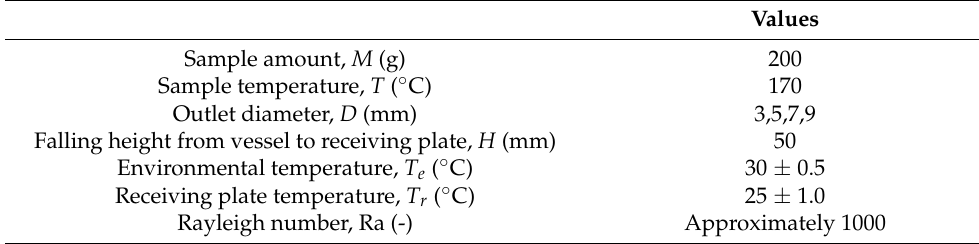
Table 3. Summary on the experiment conditions.